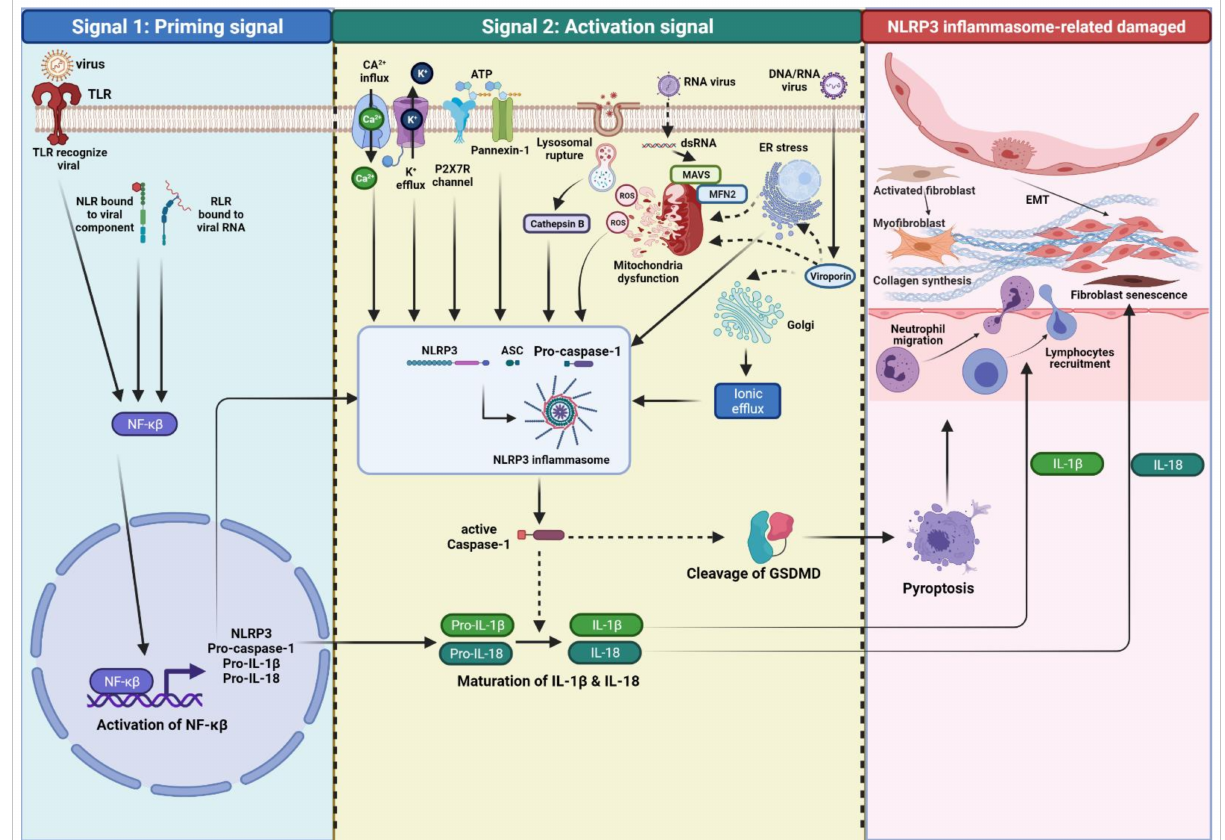
Figure 2. Overview mechanism of viral infection-induced NLRP3 inflammasome activation that drives fibrogenesis in IPF. NLRP3 inflammasome activation involves signal 1 for priming and signal 2 for complex protein assembly. Signal 1 is triggered by a DNA virus or RNA virus that is recognized as PAMPs via TLR, NLR, and RLR, leading to the upregulation and activation of the NLRP3 inflammasome, pro- caspase-1, pro-IL-1 β , and pro-IL-18 via NF- κβ activation. An additional stimulus (signal 2) is induced by multiple molecular or cellular events (DAMPs), such as lysosomal damage, mitochondrial ROS, trans-Golgi network, ER stress, K + efflux and Ca 2+ influx, K + model involving pannexin-1 and P2X7 channels. These signals promote assembly of the NLRP3 inflammasome to ASC, which then recruits pro-caspase-1 leads to the oligomerization and activation of the NLRP3 inflammasome complex. NLRP3 inflammasome activation leads to the auto-cleavage of pro-caspase-1. Activation of caspase-1 induces pyroptosis of infected cells via cleavage of GSDMD and proteolytic process of pro-IL-1 β , pro-IL-18. Pyroptosis, IL-1 β , and IL-18 are NLRP3 inflammasome-associated cellular event cytokines that implicate robust inflammation, fibroblast to myofibroblasts differentiation, synthesis of ECM, and